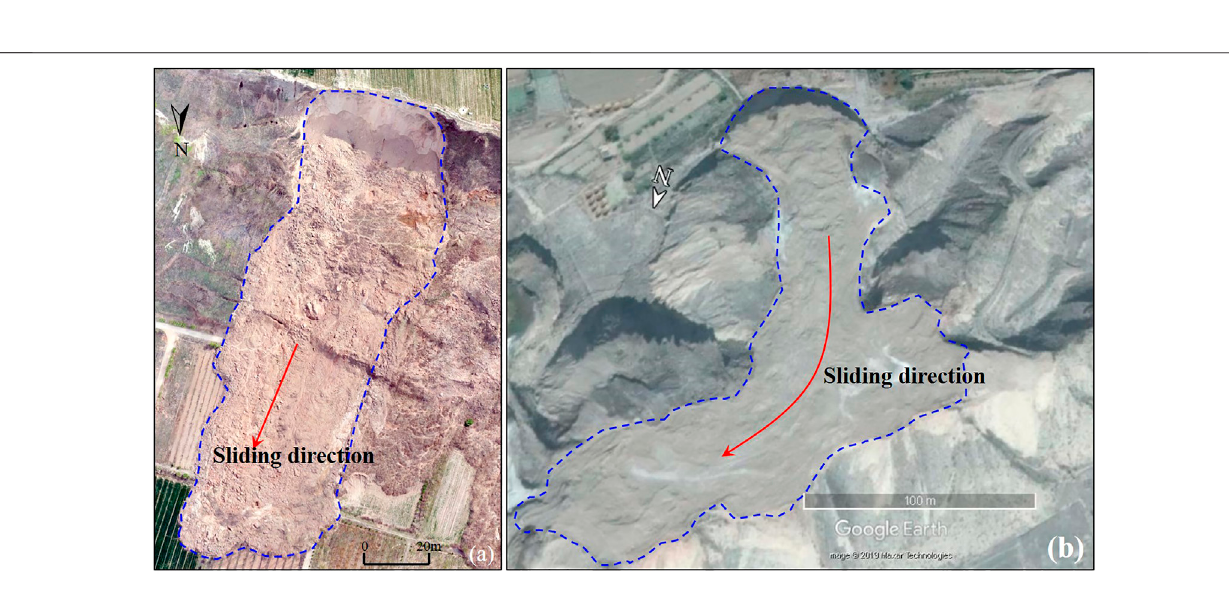
Frontiers in Earth Science |